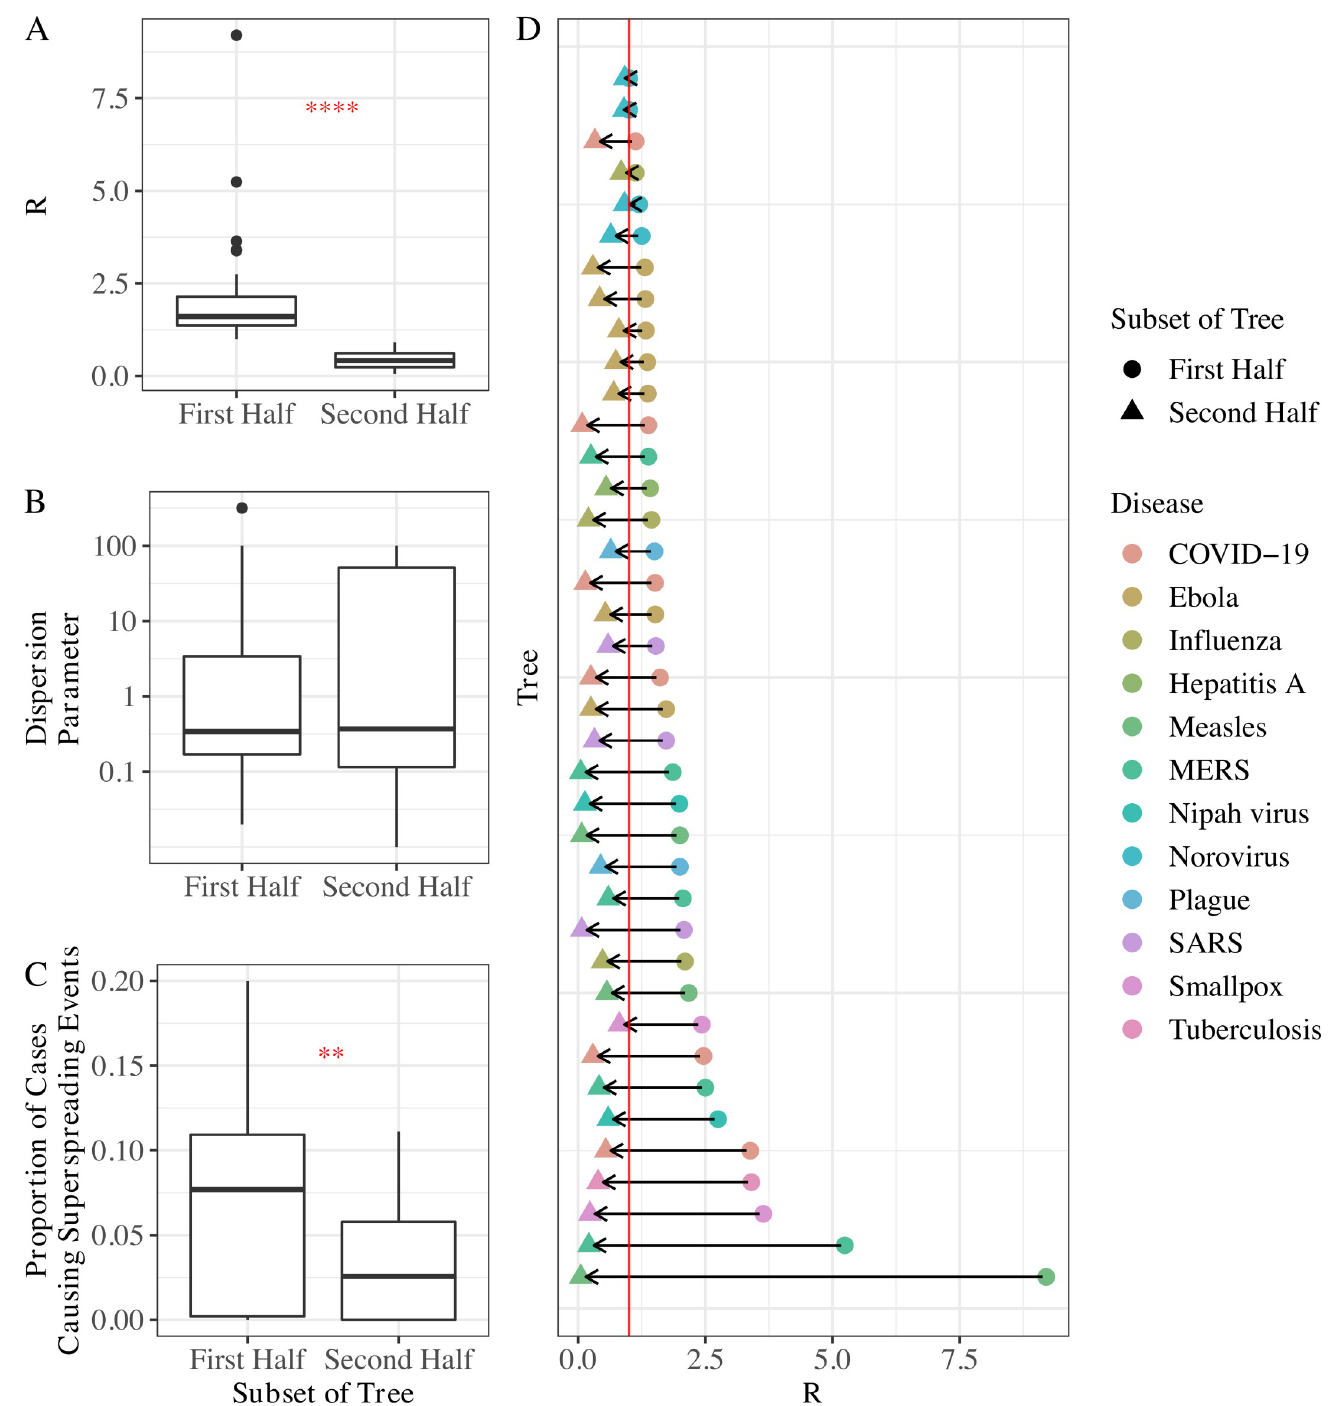
Fig 3. The time dependence of R , k , and the proportion of cases causing superspreading events. (A) R decreased significantly between the first and second halves of transmission trees. (B) k did not differ significantly between the first and second halves of transmission trees. Y-axis is on a log 10 scale for visual aid. (C) The proportion of cases causing superspreading events decreased significantly between the first and second halves of transmission trees. (D) Decrease in R shown for each tree by disease. R was below 1 in the second half of all trees; red line denotes R = 1. The Wilcoxon rank test was used for all significance tests ( � : p � 0.05, �� : p � 0.01, ��� : p � 0.001, ���� : p � 0.0001), and results are shown in red stars. Trees were assumed to be complete and only trees with 20 or more cases and at least 2 generations of spread were used in these analyses. Results assuming tree incompleteness are shown in S3 Fig. The data to reproduce this figure can be found at https://doi.org/10.5061/dryad.nk98sf7w7. COVID-19, Coronavirus Disease 2019; MERS, Middle East Respiratory Syndrome; SARS, Severe Acute Respiratory Syndrome.